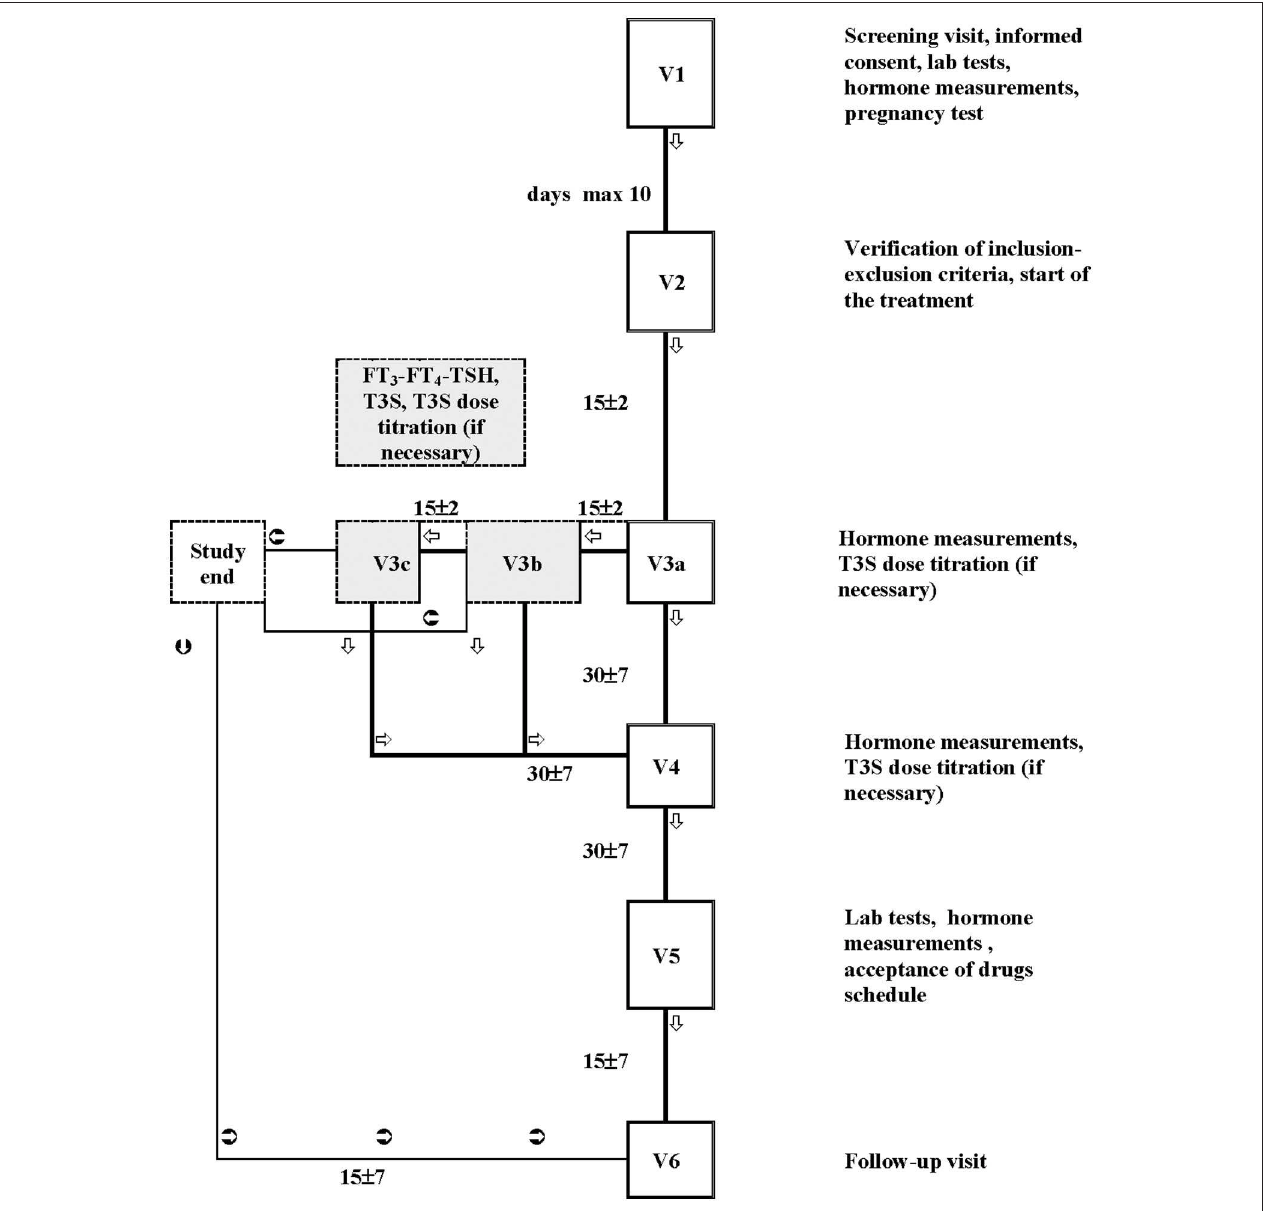
FIGURE 1 | Flow chart of the study. The study plan included a screening visit (Visit 1), in which patients potentially eligible were checked for inclusion and exclusion criteria; Visit 2 was performed within 10 days from Visit 1 to confirm the compliance with the inclusion and the exclusion criteria; if confirmed, the L-T4 therapy schedule was changed to L-T4 T3S. The next visits (max 3 visits: V3a, V3b, and V3c) were performed every 15 days and were dedicated to T3S titration. If during the + titration period the patients maintained (or attained) the metabolic control (i.e., hormonal parameters in the accepted range), the T4 until the next follow-up visit (Visit 4, 1 month after), when a T3S dosage change was allowed. A fifth visit (visit 5) was performed after a further month of therapy. If at the end of the titration period (visit 3c) patients did not attained the metabolic control, they were removed from the study. Intermediate visit(s) were arranged in case of adverse events or whenever judged suitable for patient safety by the investigator. A safety follow-up visit (visit 6) was arranged 15 (